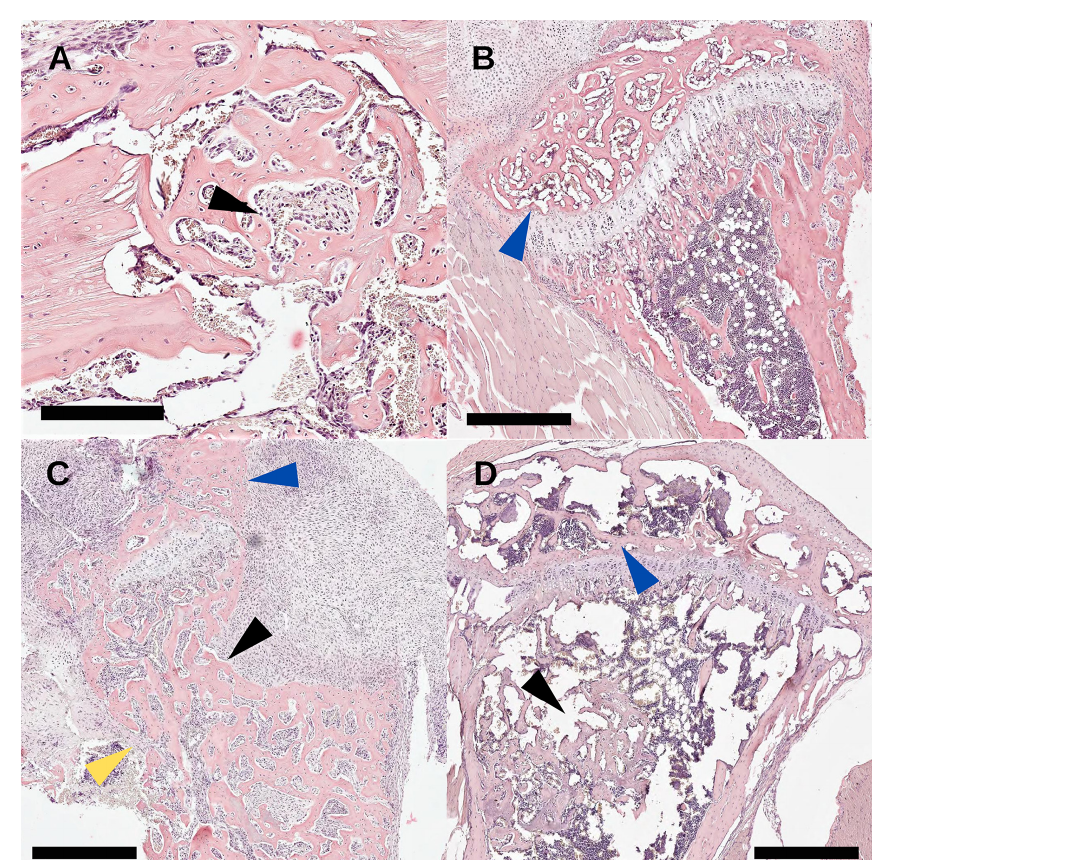
Figure 7. Study 2. Histology sections with H&E staining (scale bar: 500µm) of (a) an uninfected drilled hole (black arrow) with > 90% healing 2 weeks post-surgery; (b) an uninfected tibial condyle (blue arrow) with > 90 healing from pin disruption; (c) an infected tibia with TDH-pin insertion where severe osteolysis (back arrow) of the anterior tibia was seen, the tibial condyle was woven by reabsorption (blue arrow), and the cortical bone (yellow arrow) structure was breaking down; and (d) an NIS infected tibia where the tibial condyle (blue arrow) was less affected than the TDH model and the healing of the bone defect (black arrow) was